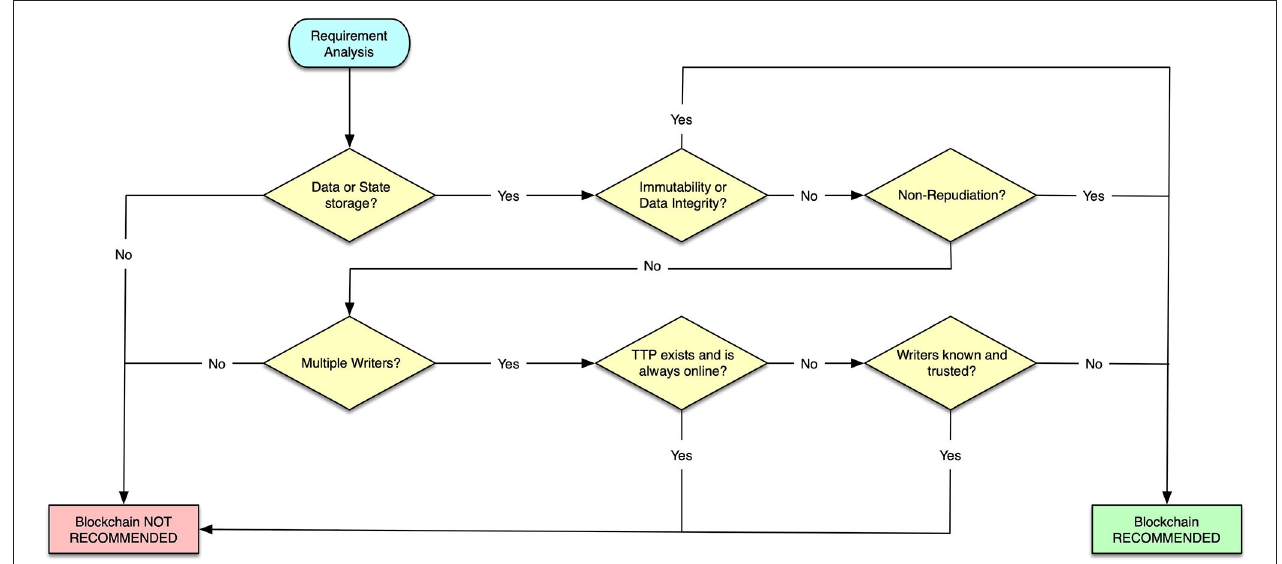
FIGURE 9 | Flowchart: blockchain, yes or no? adapted from